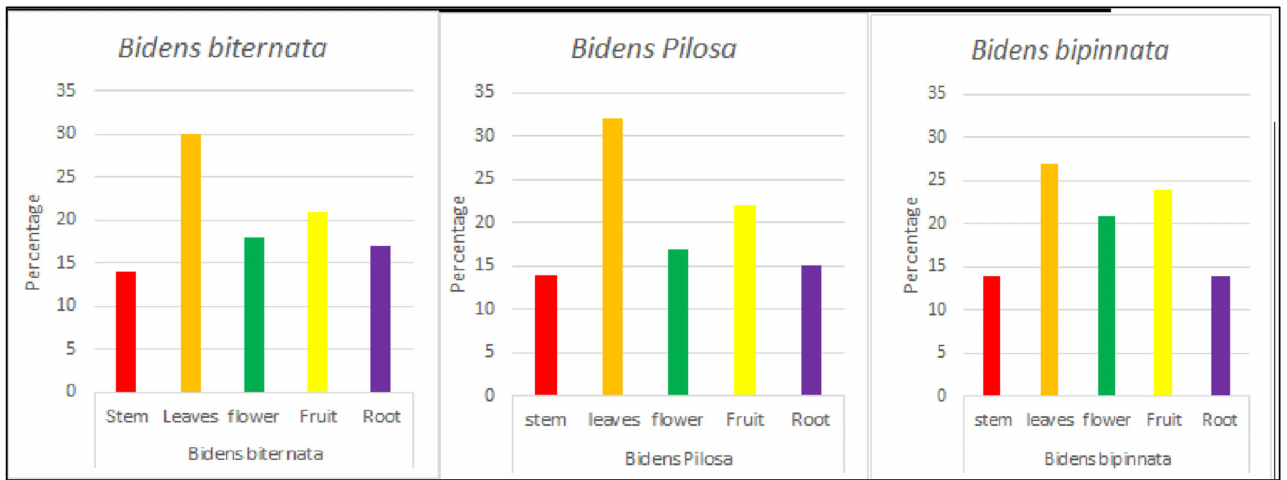
Figure 1. The percentage yield of plants obtained.